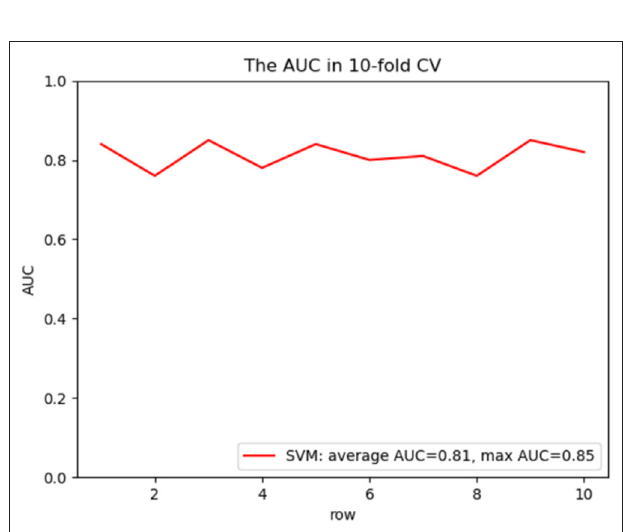
FIGURE 7 | ROC curve analysis of a 10-fold cross validation of SVM model for predicting the risk of recollapse following PKP with average AUC 0.81 and maximum AUC 0.85.